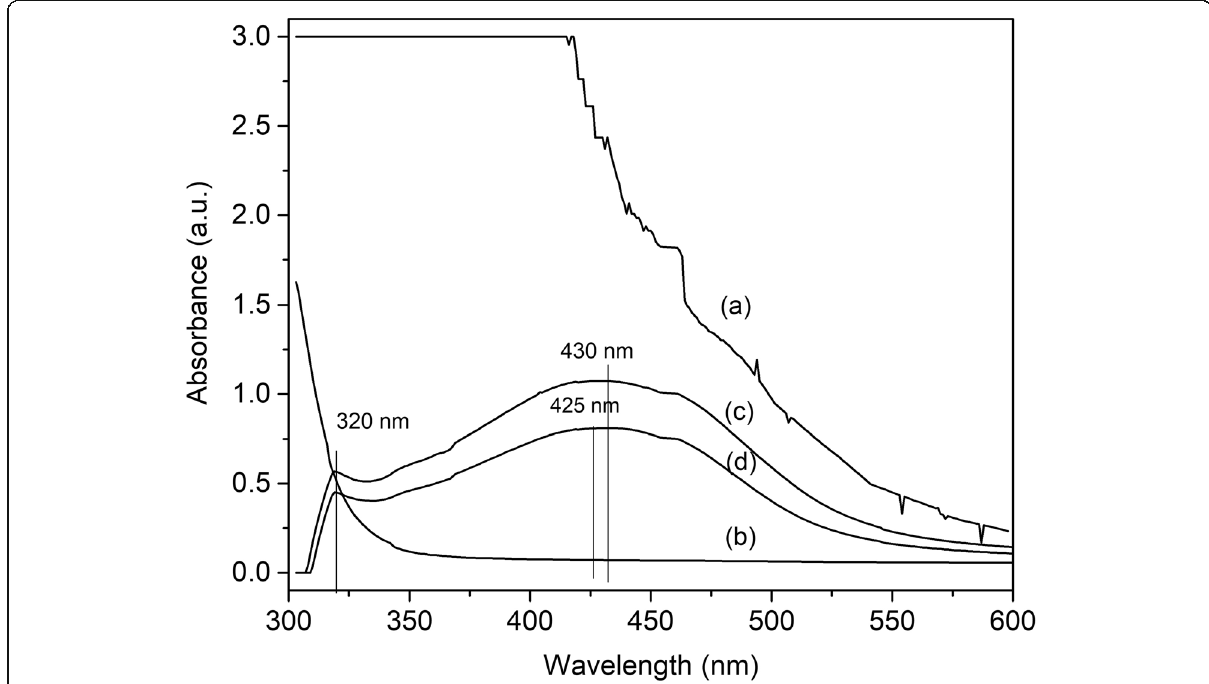
Fig. 1 UV-visible absorption peak of a silk sericin (SS), b AgNO 3 , c 1:6 SS-AgNPs, and d 1:8